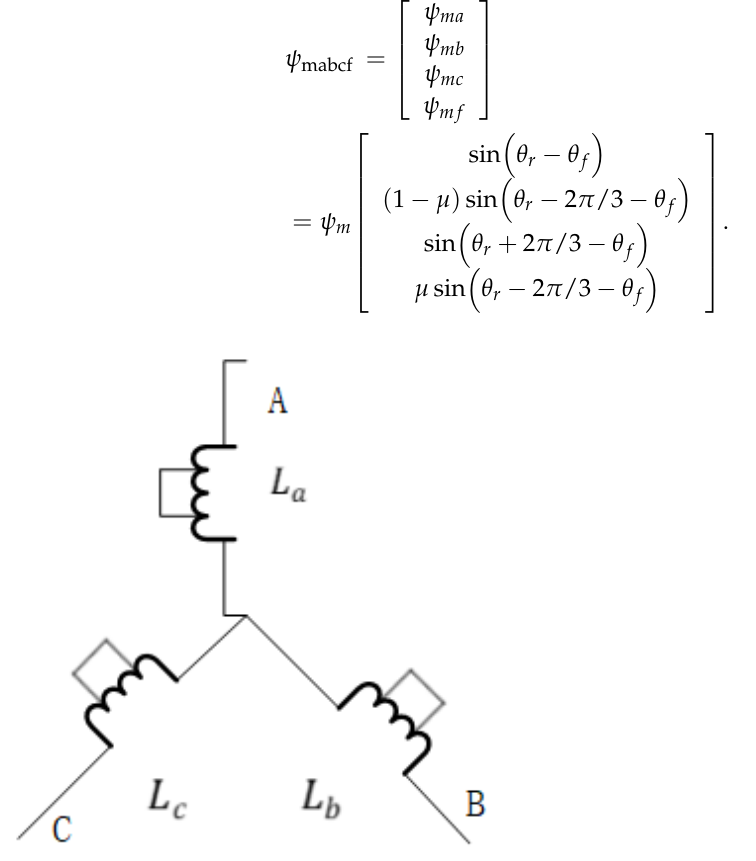
Figure 1. The schematic of PMSM with Inter-turn fault.